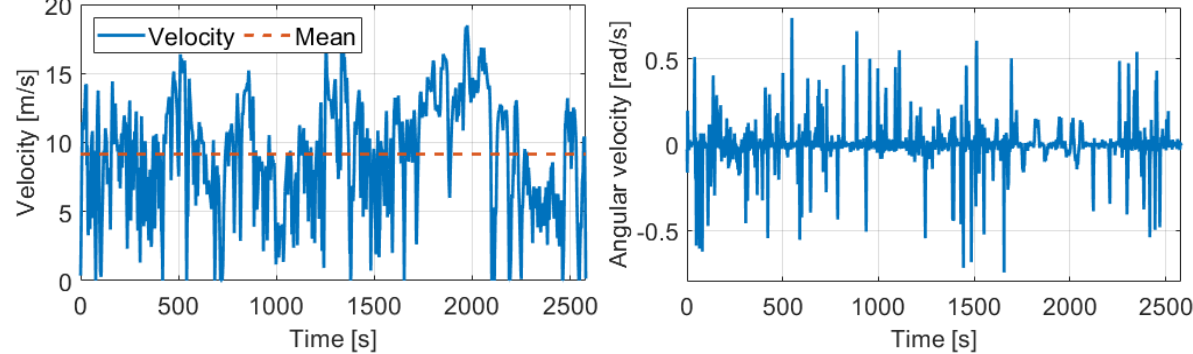
Figure 16. Path of the used measurements.